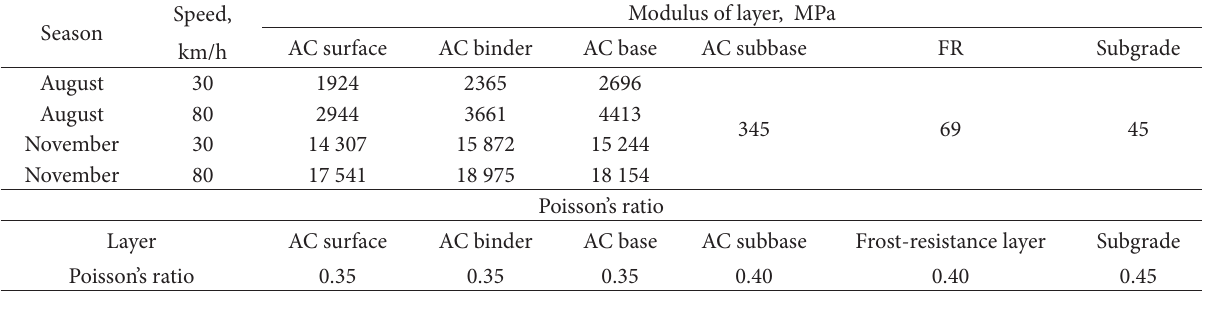
Table 2. Material property used in analysis